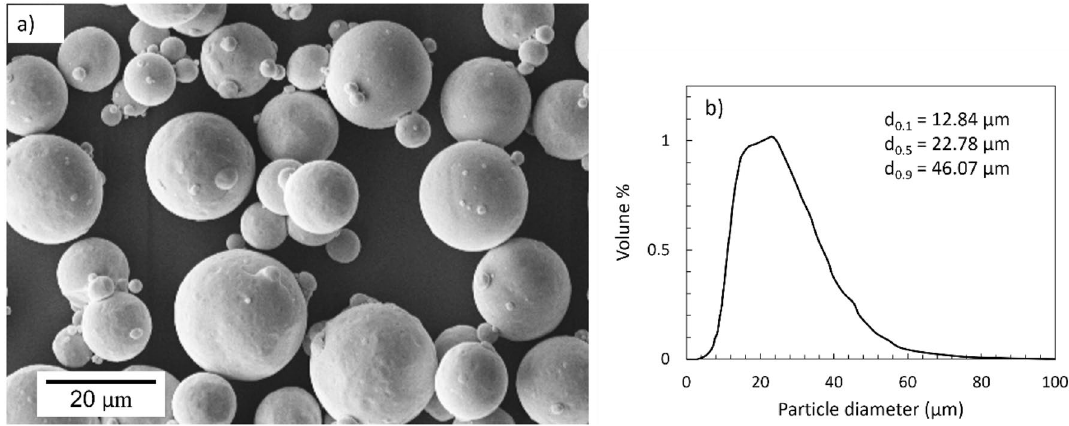
Figure 1. SEM micrograph ( a ) and size distribution ( b ) of copper powder